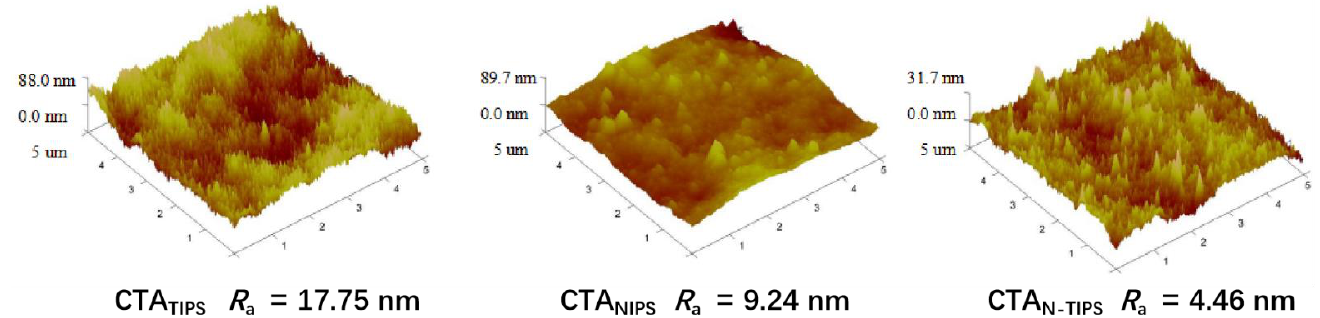
Figure 2. AFM images of CTA porous substrates.